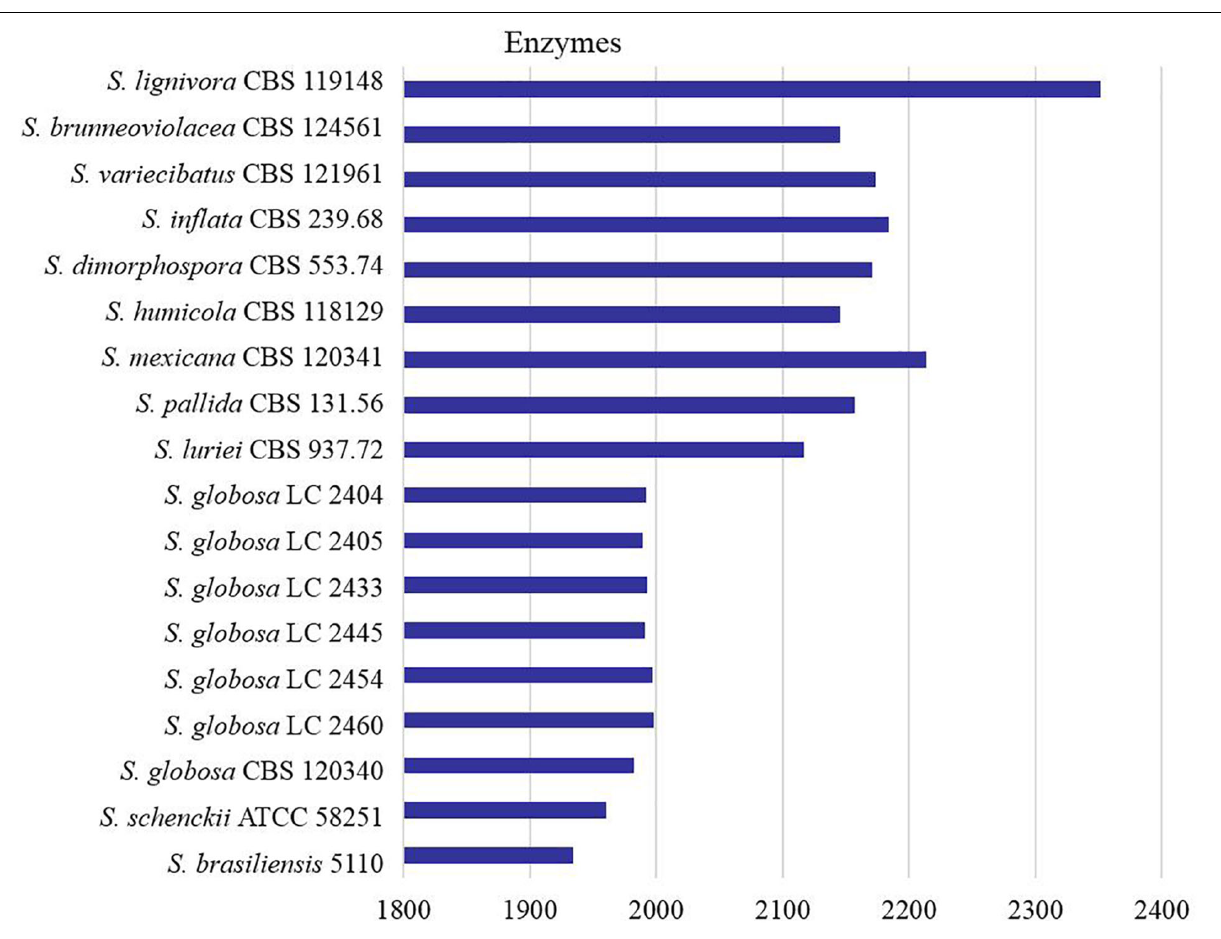
Frontiers in Microbiology |